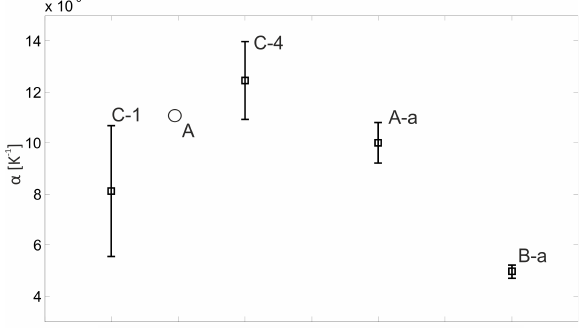
Figure 5. Thermal expansion coefficient α of investi- gated specimens, loaded in the 18-100 °C temperature interval. The value marked "A" represents an average value of α determined by [7] on large set of marble